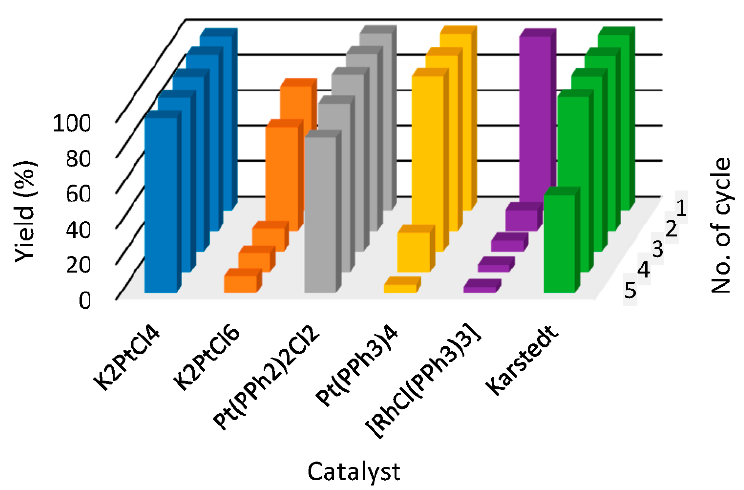
Figure 3. The yields of hydrosilylation reaction carried out in [P 44414 ][NTf 2 ] ( 1 ) (tributyltetradecylphosphonium bis(trifluoromethylsulfonyl)imide) in subsequent cycles. Colors refer to different catalysts used in hydrosilylation reaction.